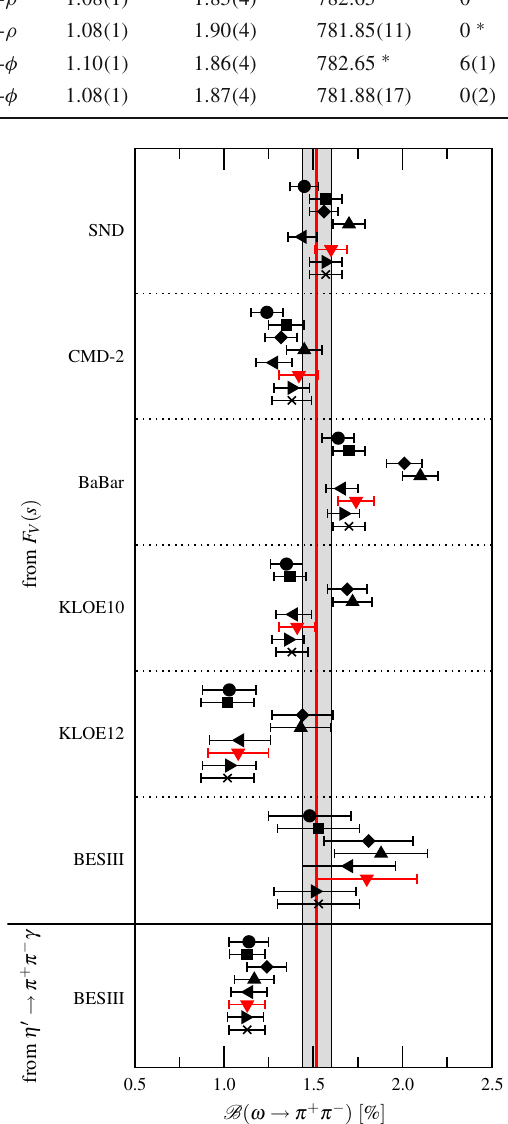
Fig. 1 Comparison of the values for the branching ratio for ω → π + π − extracted from the various fits to the different data sets, where circles refer to Fit 1, squares to Fit 2, diamonds to Fit I, the triangles- up to Fit II, triangles-left to Fit 1- ρ , (red) triangles-down to Fit 2- ρ , triangles-right to Fit 1- φ , and crosses to Fit 2- φ . The red thick solid line denotes the average of the values, the gray band the corresponding uncertainty found from our preferred analysis – Fit 2- ρ – including all data sets. Note that the values extracted from η (cid:7) → π + π − γ refer to pseudo-data generated according to preliminary